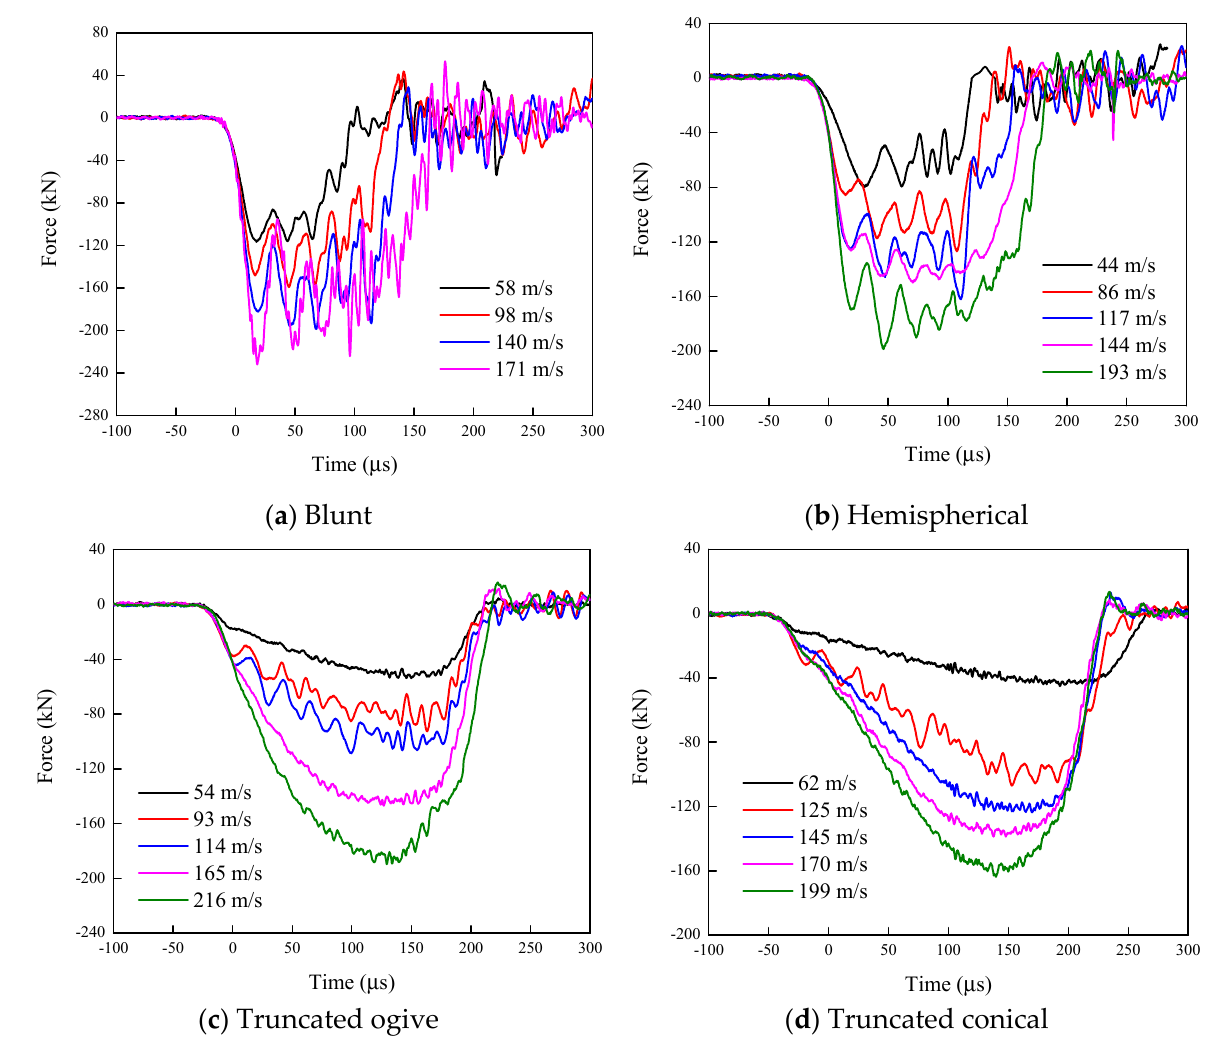
Figure 17. Impact load curve for varying impact velocities for the projectiles.